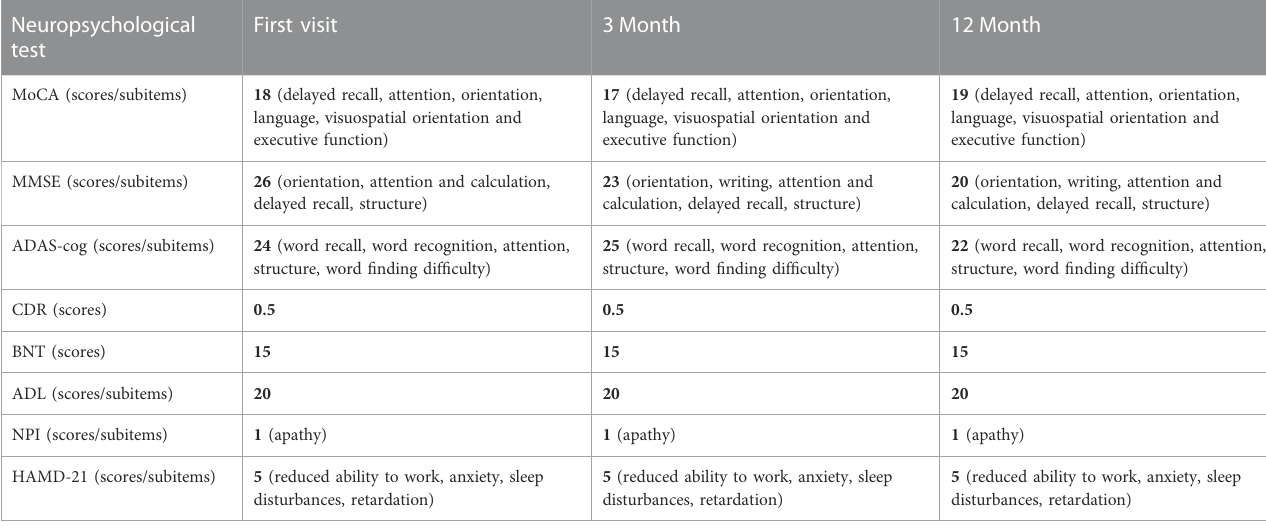
TABLE 1 Neuropsychological scale outcomes for the fi rst visit and follow-up. Neuropsychological